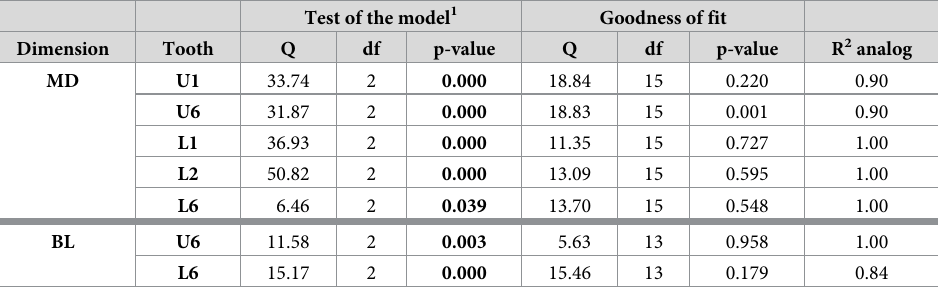
Table 5. Meta-regression for the effect on the differences in permanent teeth dimensions between preterm and full-term children. Statistics for the multivariate regression